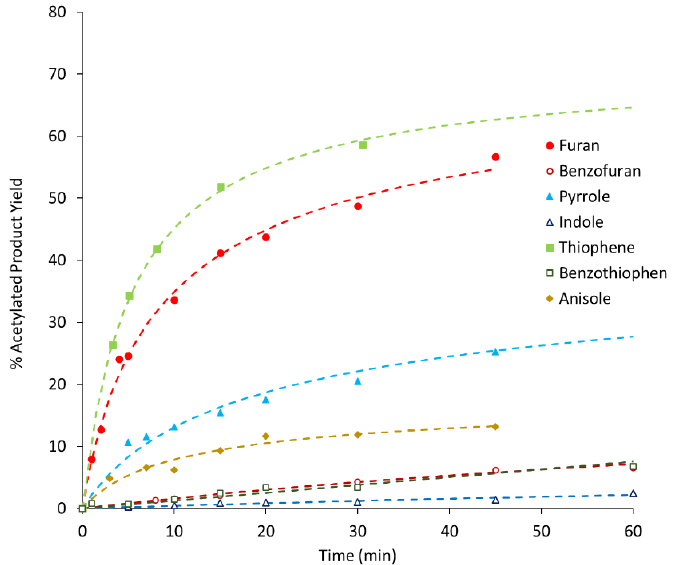
Figure 1. Product yield as a function of reaction time using BEA as the catalyst (the dashed curves represent calculated values resulting from the application of the kinetic model).